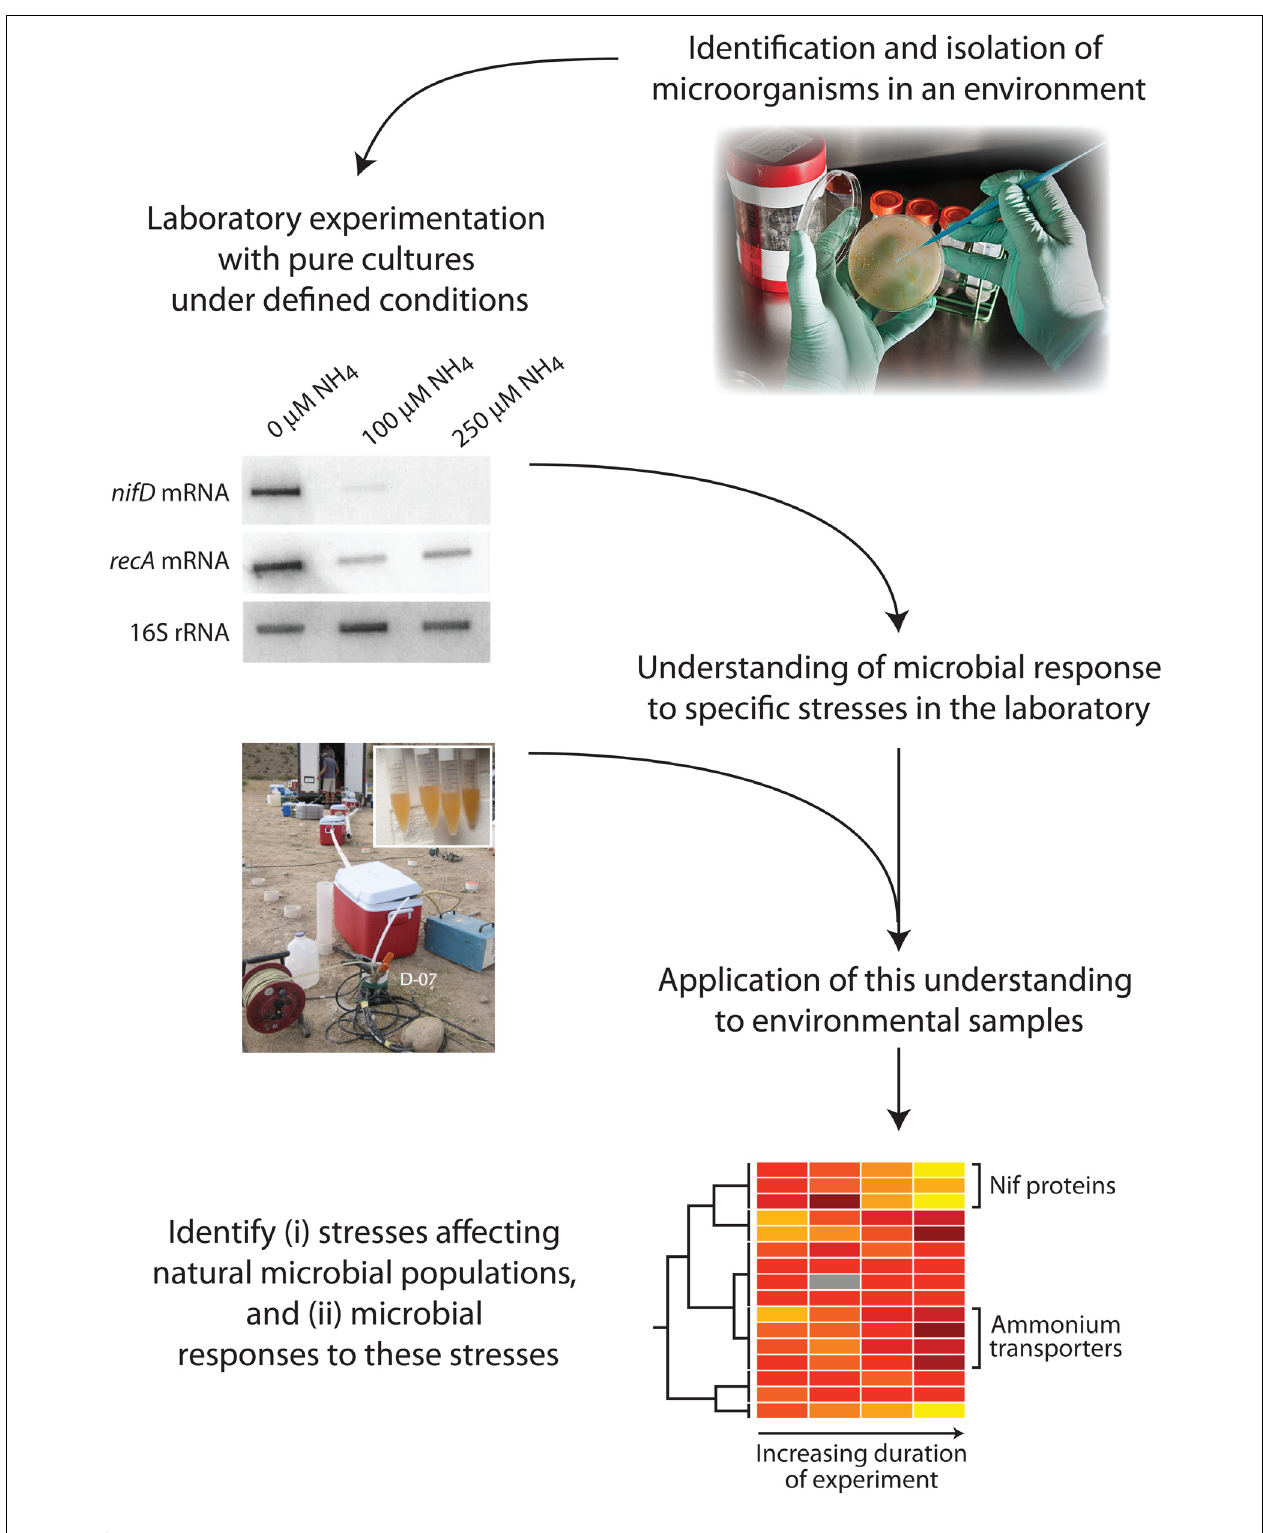
FIGURE 1 | Steps involved in the identification of physiological indicators and their application to natural microbial communities. A pure culture isolated from the environment is exposed to a range of physicochemical conditions hypothesized to be relevant to the in situ